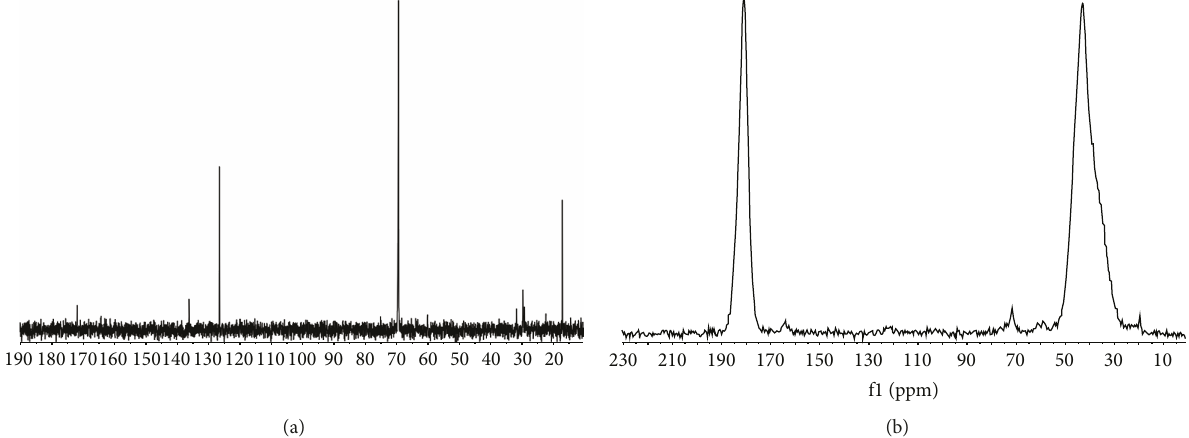
Figure 2: 13 C NMR spectra of DPA in D